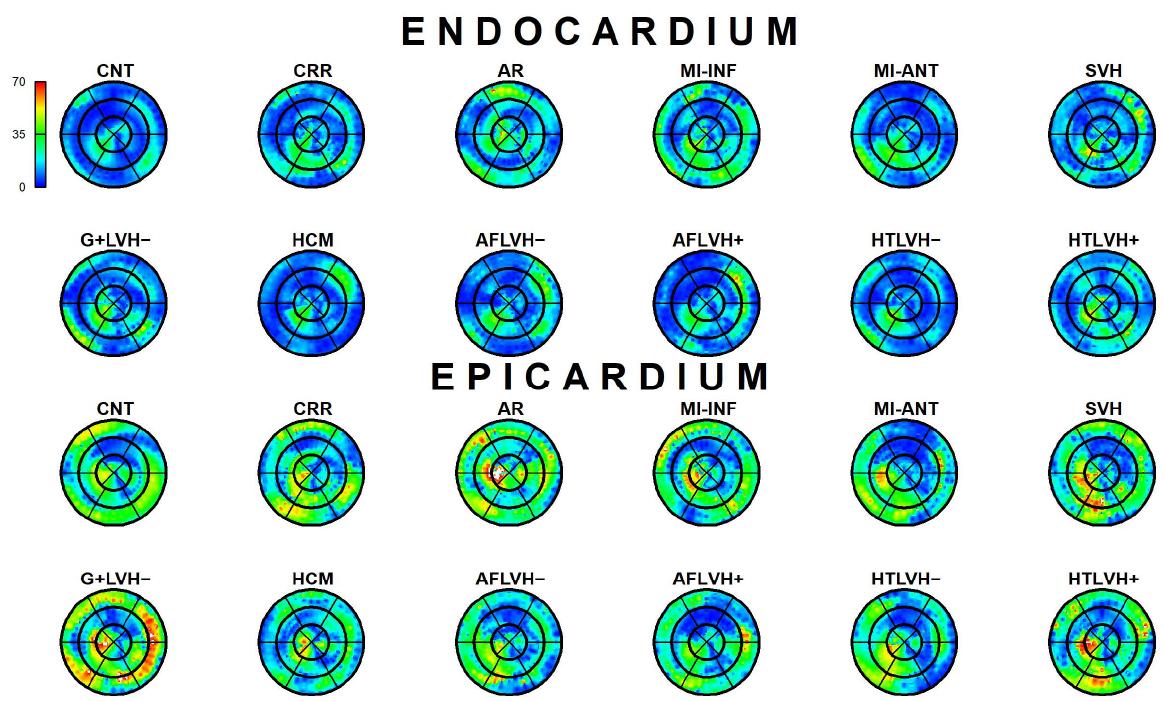
Figure 5. Per-category and per-landmark median values of α p absolute values in degrees for both Epi- and Endocardium. Regions are colored according to the color bar at top left. Abbreviations: Control healthy subjects (CNT), Cirrhosis (CRR), Aortic regurgitation (AR), Myocardial infarction of inferior wall (MI-INF), Myocardial infarction of anterior wall (MI-ANT), Mutation carriers for hypertrophic cardiomyopathy with LV hypertrophy (HCM), Secondary ventricular hypertrophy (SVH), Mutation carriers for hypertrophic cardiomyopathy without LV hypertrophy (G+LVH−), Atrial fibrillation without ventricular hypertrophy (AFLVH−), Atrial fibrillation with ventricular hypertrophy (AFLVH+), Hypertension without LV hypertrophy (HTLVH−), and Hypertension with LV hypertrophy (HTLVH+).